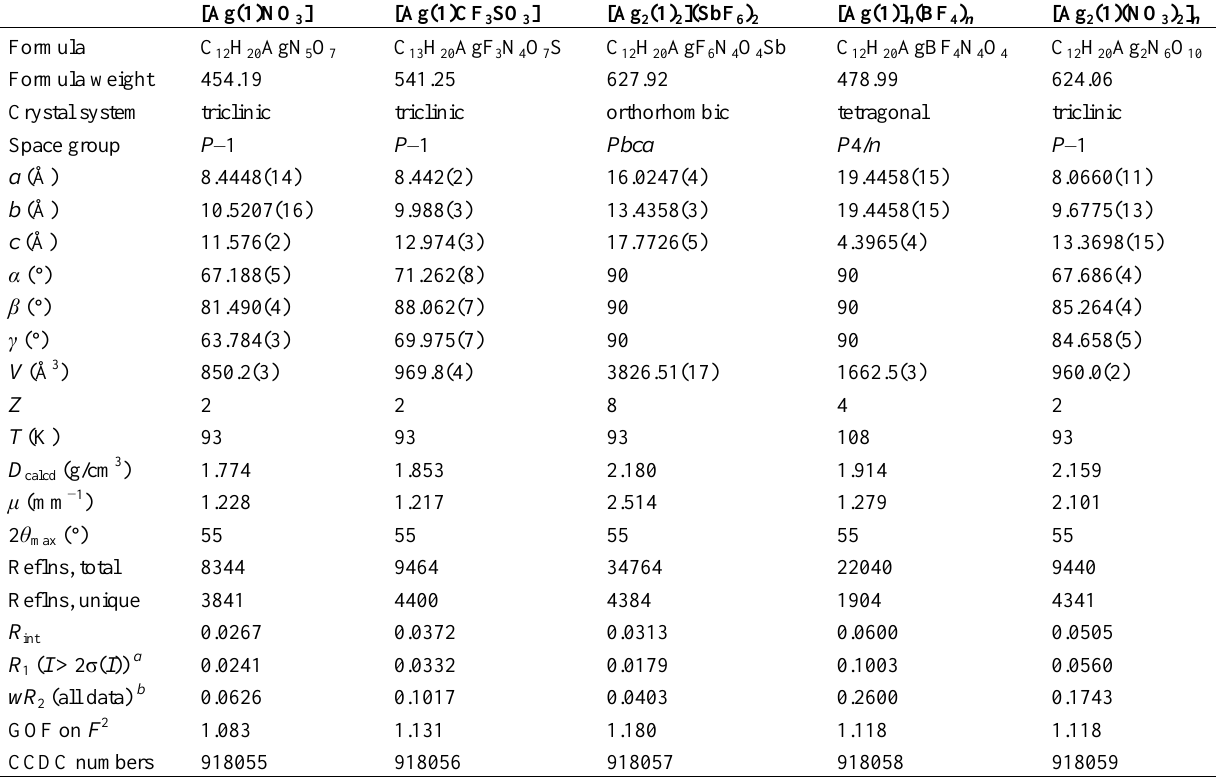
], [Ag( 1 )CF SO 3 3 3